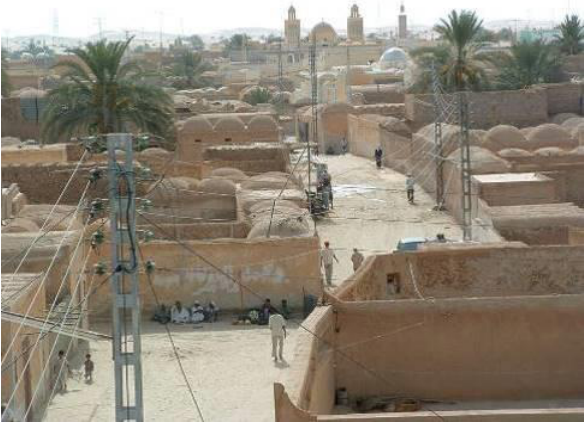
Figure 1. Landscape of Guemar city,